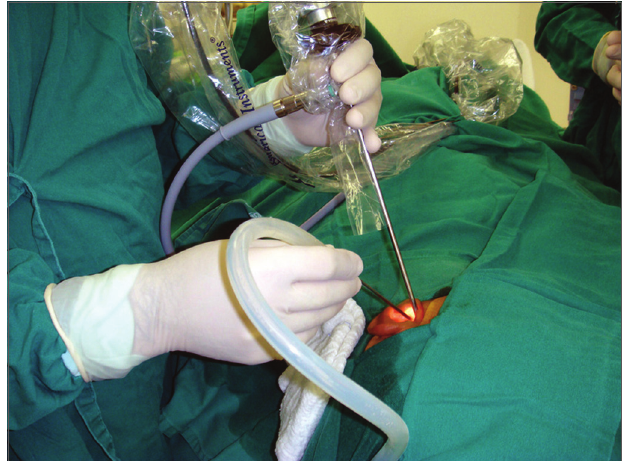
Figura 7. Figura evidenciando o posicionamento do endoscópio no conduto auditivo externo, bem como o posicionamento das mãos, uma segurando o endoscópio e a outra, os instrumentos. Note que as mãos estão em planos horizontais